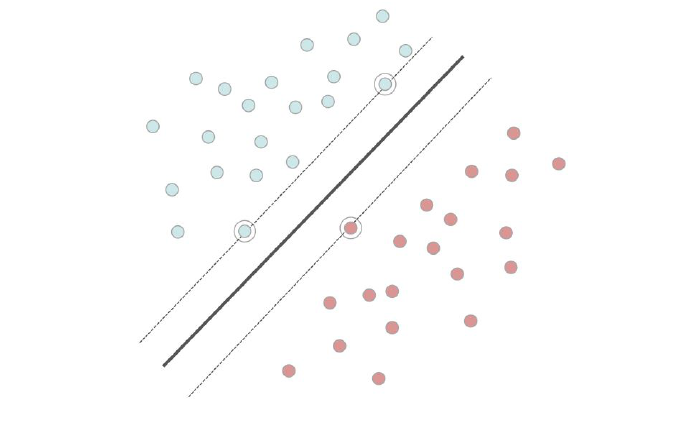
Figure 2. Support Vector Machine hyperplane, in which blue spots are positive samples, pink spots correspond to the negative samples, the rimmed ones are the support vectors, and the central thicker line is the obtained optimal hyperplane